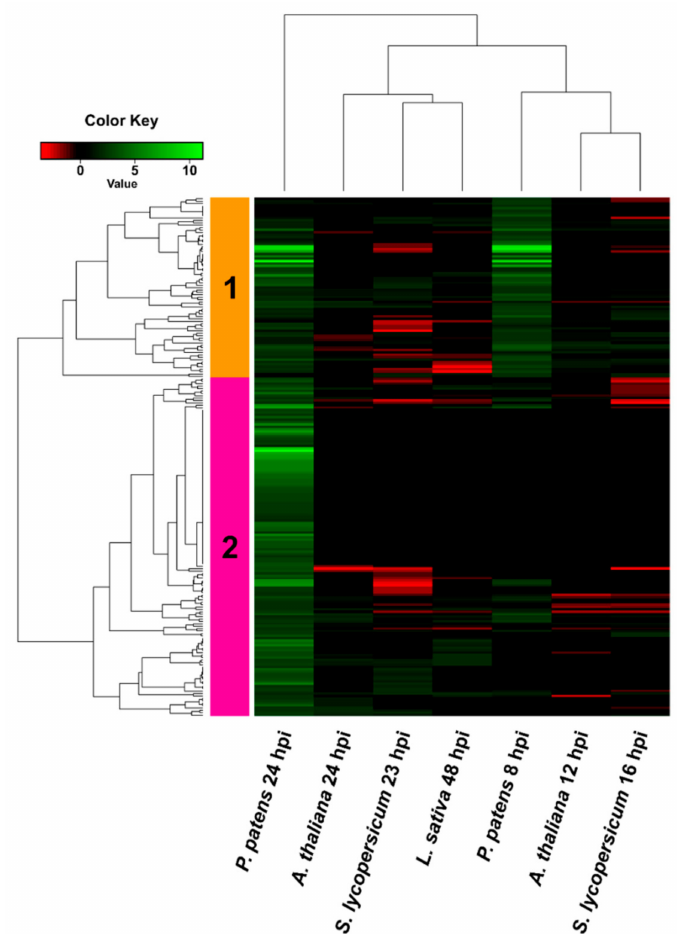
Figure 7. Hierarchical clustering (heat map) showing B. cinerea genes only upregulated in P. patens . DEGs correspond to the 216 genes that were only upregulated when growing in P. patens . Selected DEGs had log2 FC ≥ 2, FDR ≤ 0.05, and were expressed differentially in at least one time point for each plant species. For samples where no significant difference with control was observed (FDR > 0.05) or no data was available, the log2 FC was assigned as cero. See Table S13 for complete